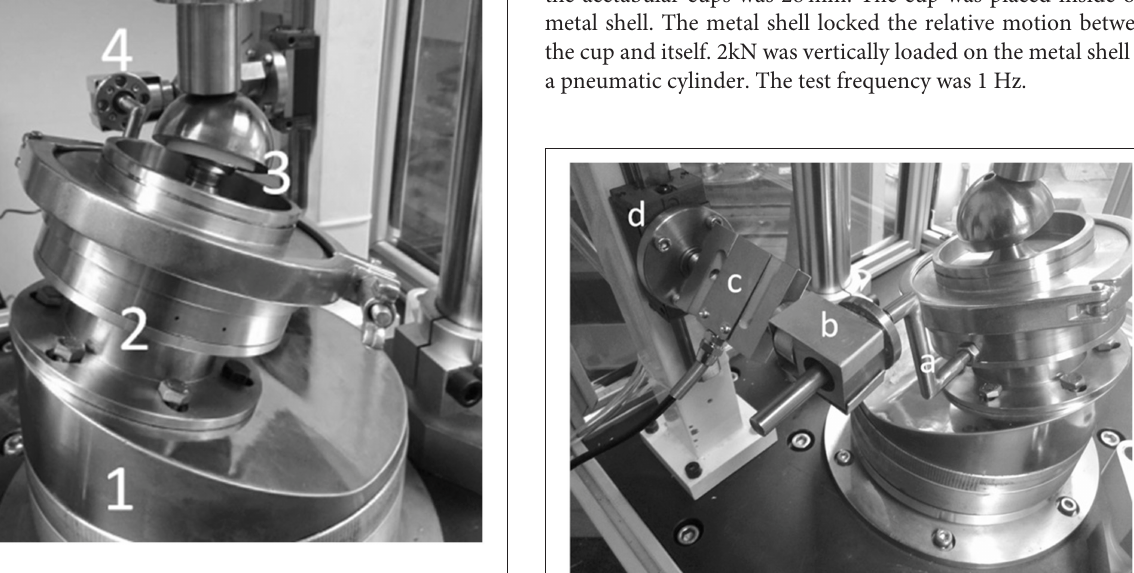
FIGURE 1 | The main module of the biotriboligical hip joint simulator (HSMS 4203 ) without lubrication: (1) Slope module, (2) bearing housing, (3) reaction articulating surfaces, (4) friction measurement module, (5) force sensor.